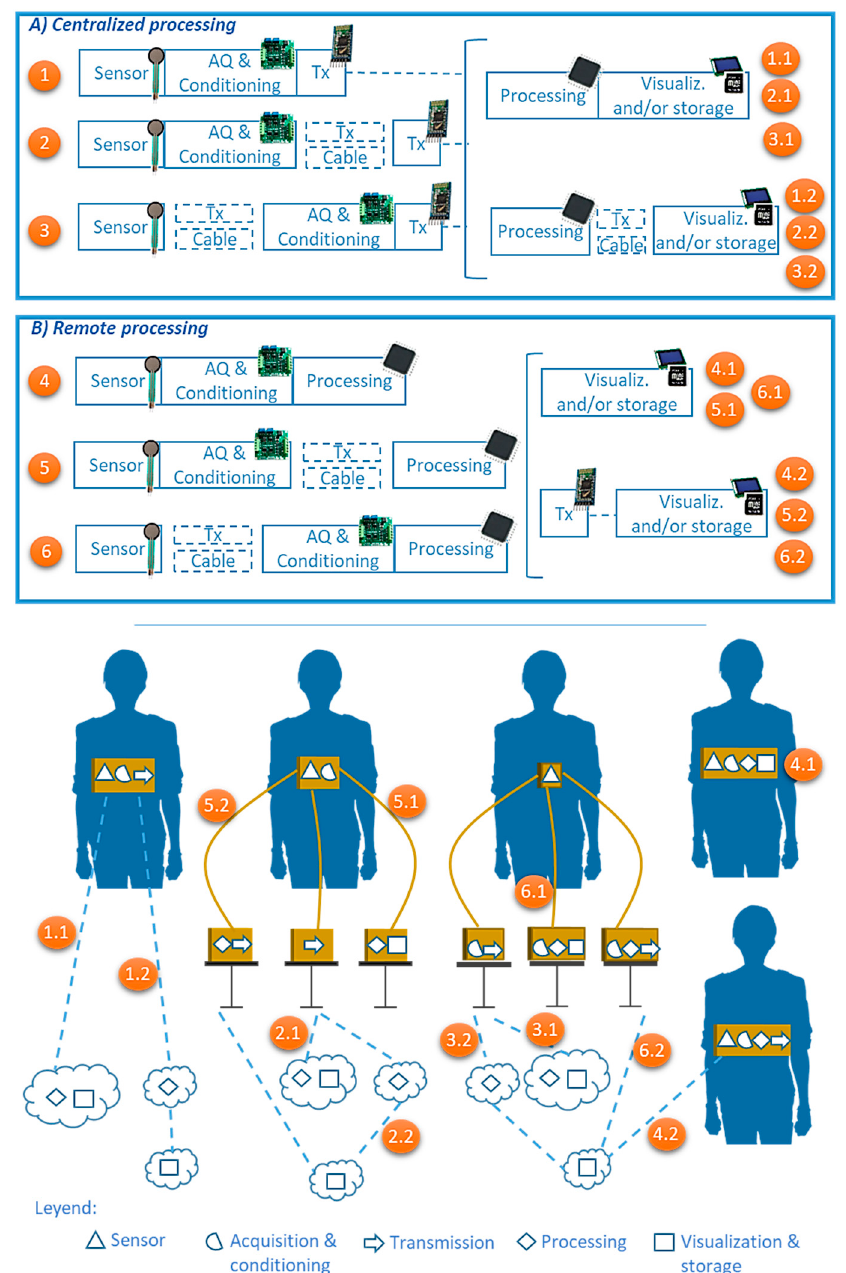
Figure 11. Representation of possible setups of respiratory sensing systems. ( A ) perform data processing on a centralized processing platform and ( B ) perform data processing near the remote sensing unit. Communication